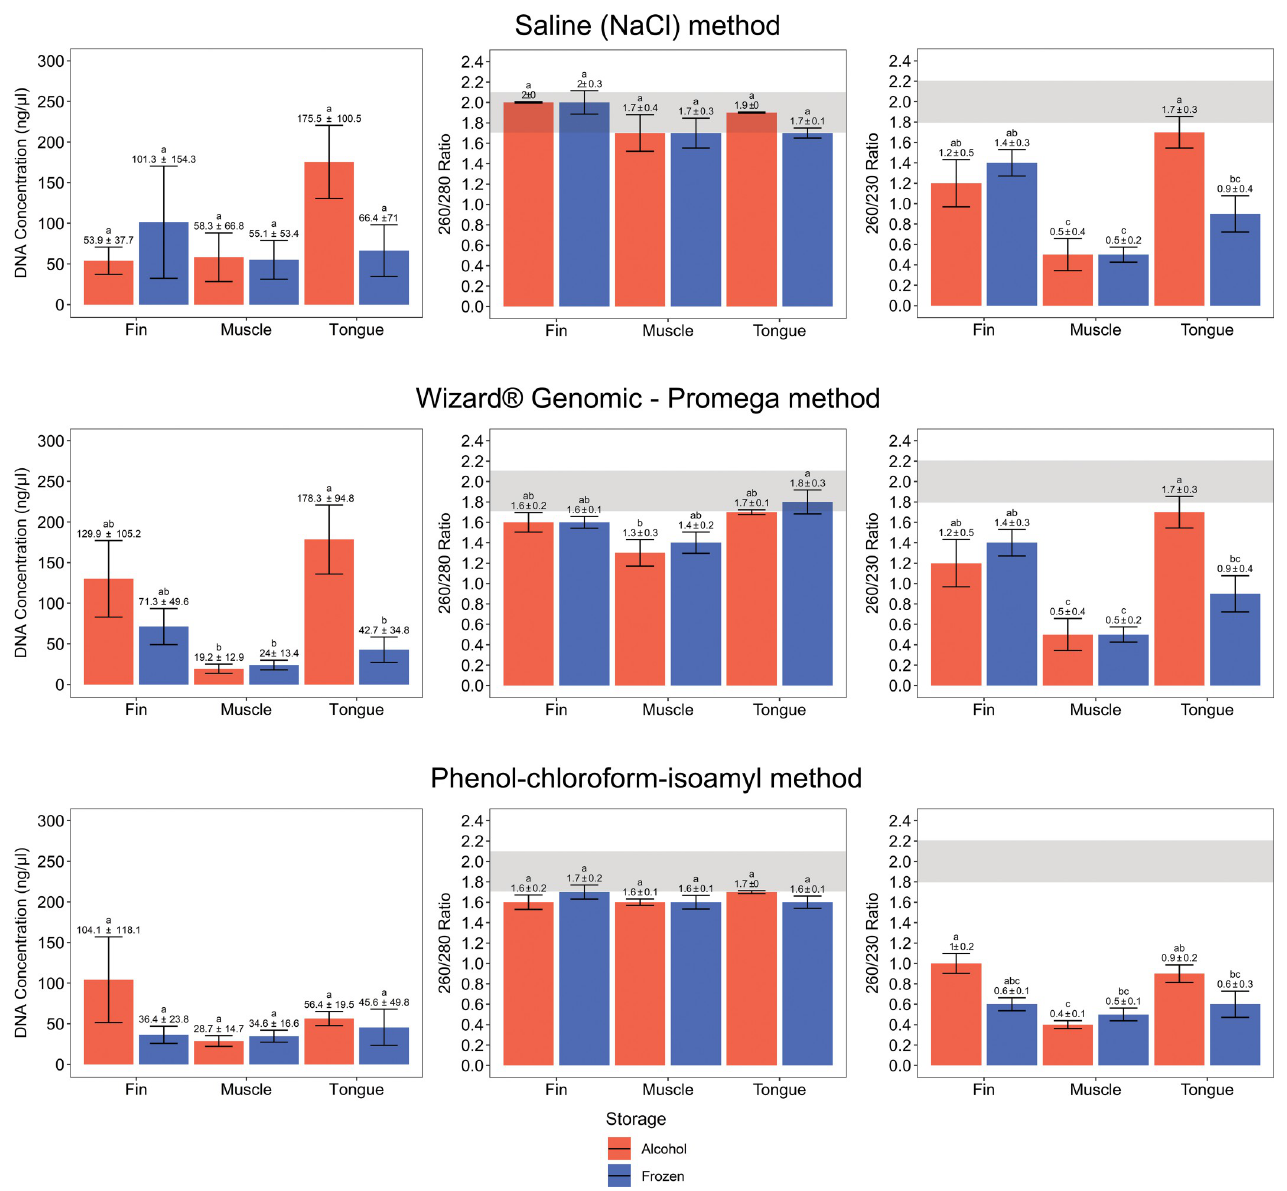
Fig 3. DNA concentration, 260/280 and 260/230 purity ratio for the three protocols of DNA extraction according to tissue type and storage conditions. Gray shaded areas indicate the ratio of purity values considered satisfactory for extracted DNA. Error bars indicate standard deviations for the five independent replicates. Different letters indicate significant differences ( p < 0.05) from each comparative